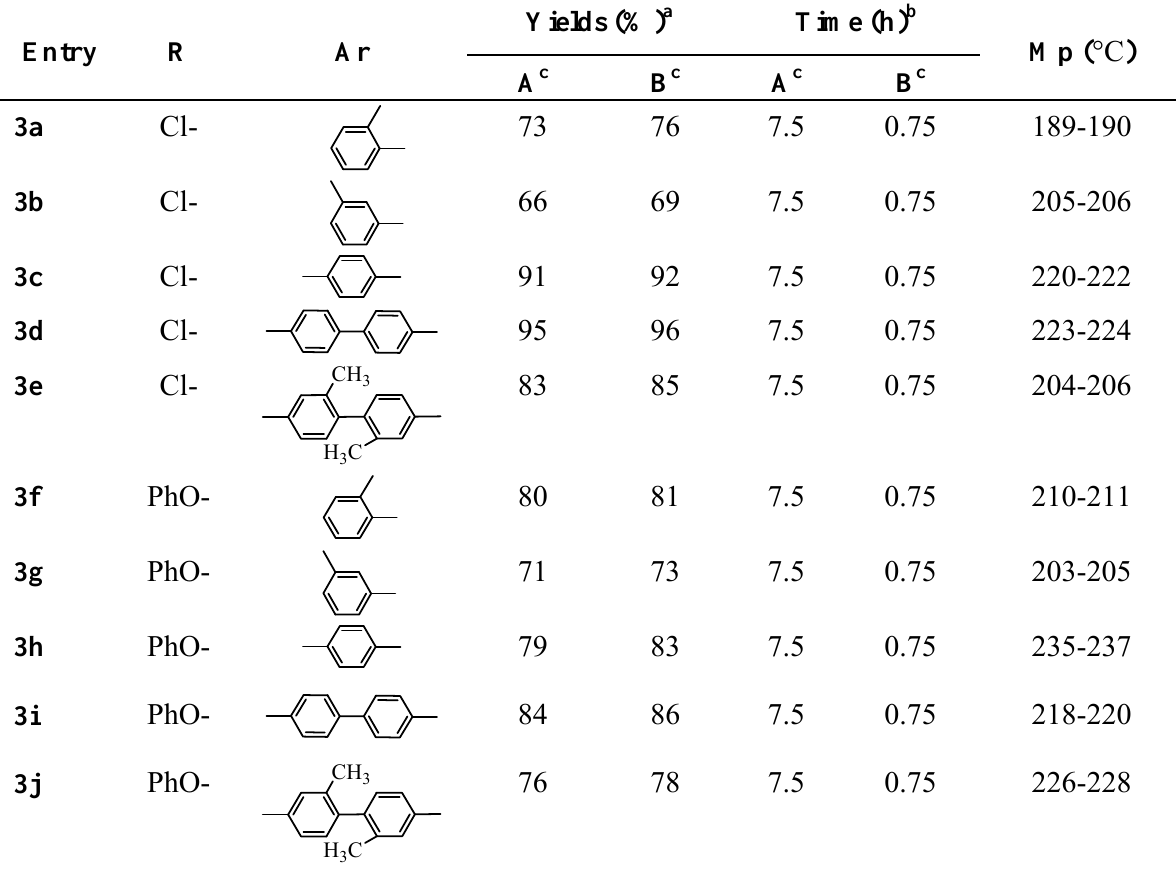
Table 1. Comparison between ultrasound irradiation and conventional